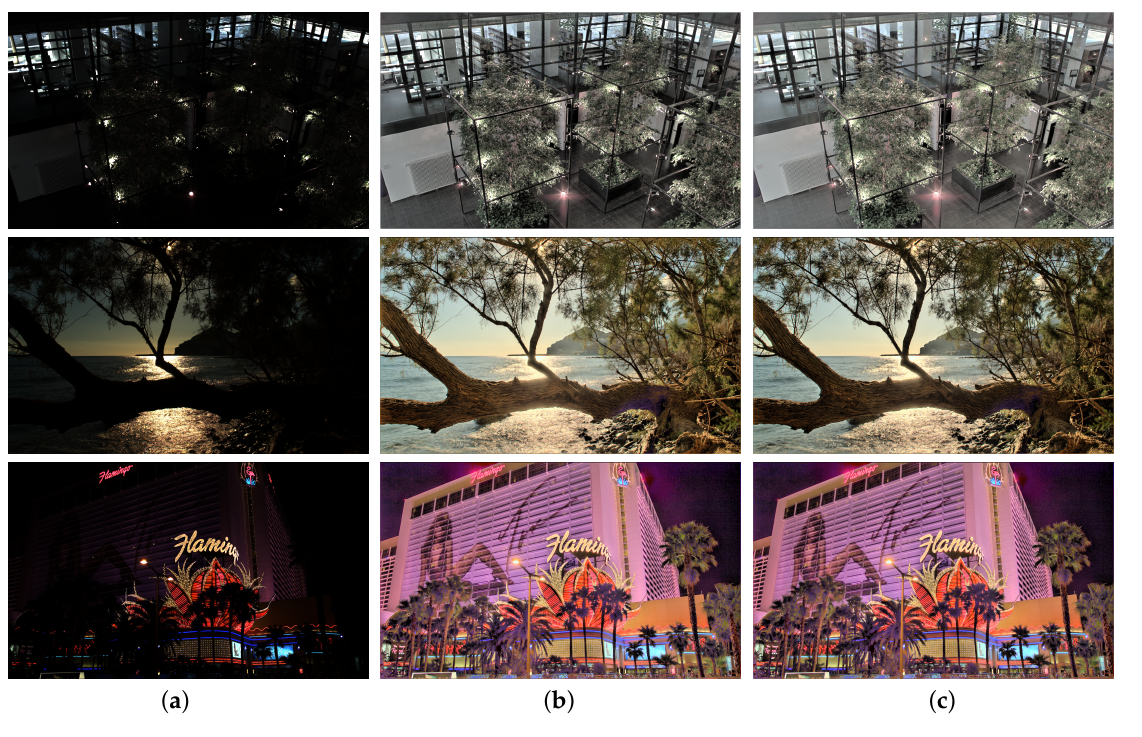
Figure 12. Comparison of the results of the DNN-based TM algorithm in different preprocessing methods: ( a ) radiance map; ( b ) ACC [21]; ( c ) AdaLogT.